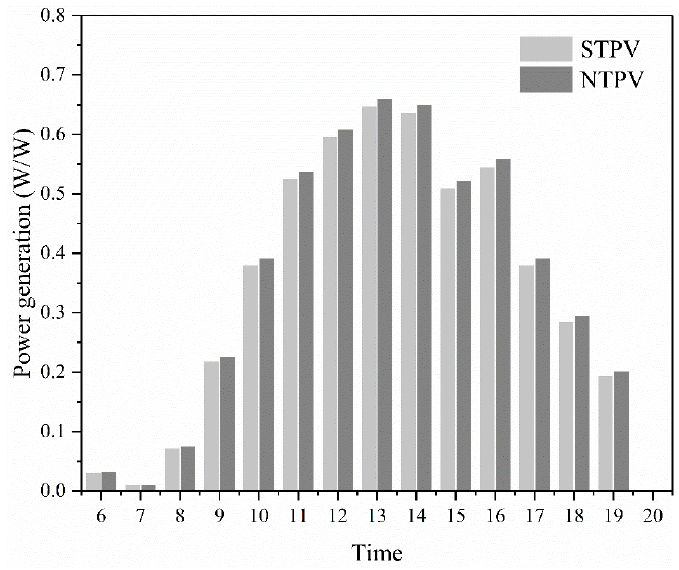
Figure 8. Power generation of the two modules.